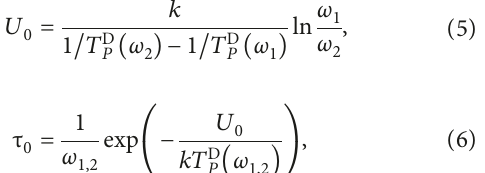
12 μ m; 3-Zr-HEAD, d (cid:29) 117nm; 6-Zr-02RT, d (cid:29)